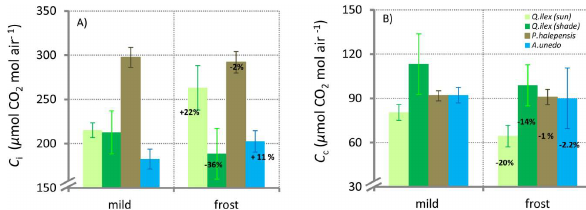
2 3 Figure 6. Bar plot of the effect of a sudden period of frost following a mild winter period on (a) the stomatal internal CO 2 concentra- tion ( C i ) and (b) the chloroplastic CO 2 concentration ( C c ) in sunlit leaves of Q. ilex (light green bar), in shaded leaves of Q. ilex (dark green bar), P. halepensis (beige bar) and A. unedo (blue bar). The error bars represent the standard error, and the percentages indicate the change between periods where significance is indicated with an asterisk ( P ≤ 0 . 05).